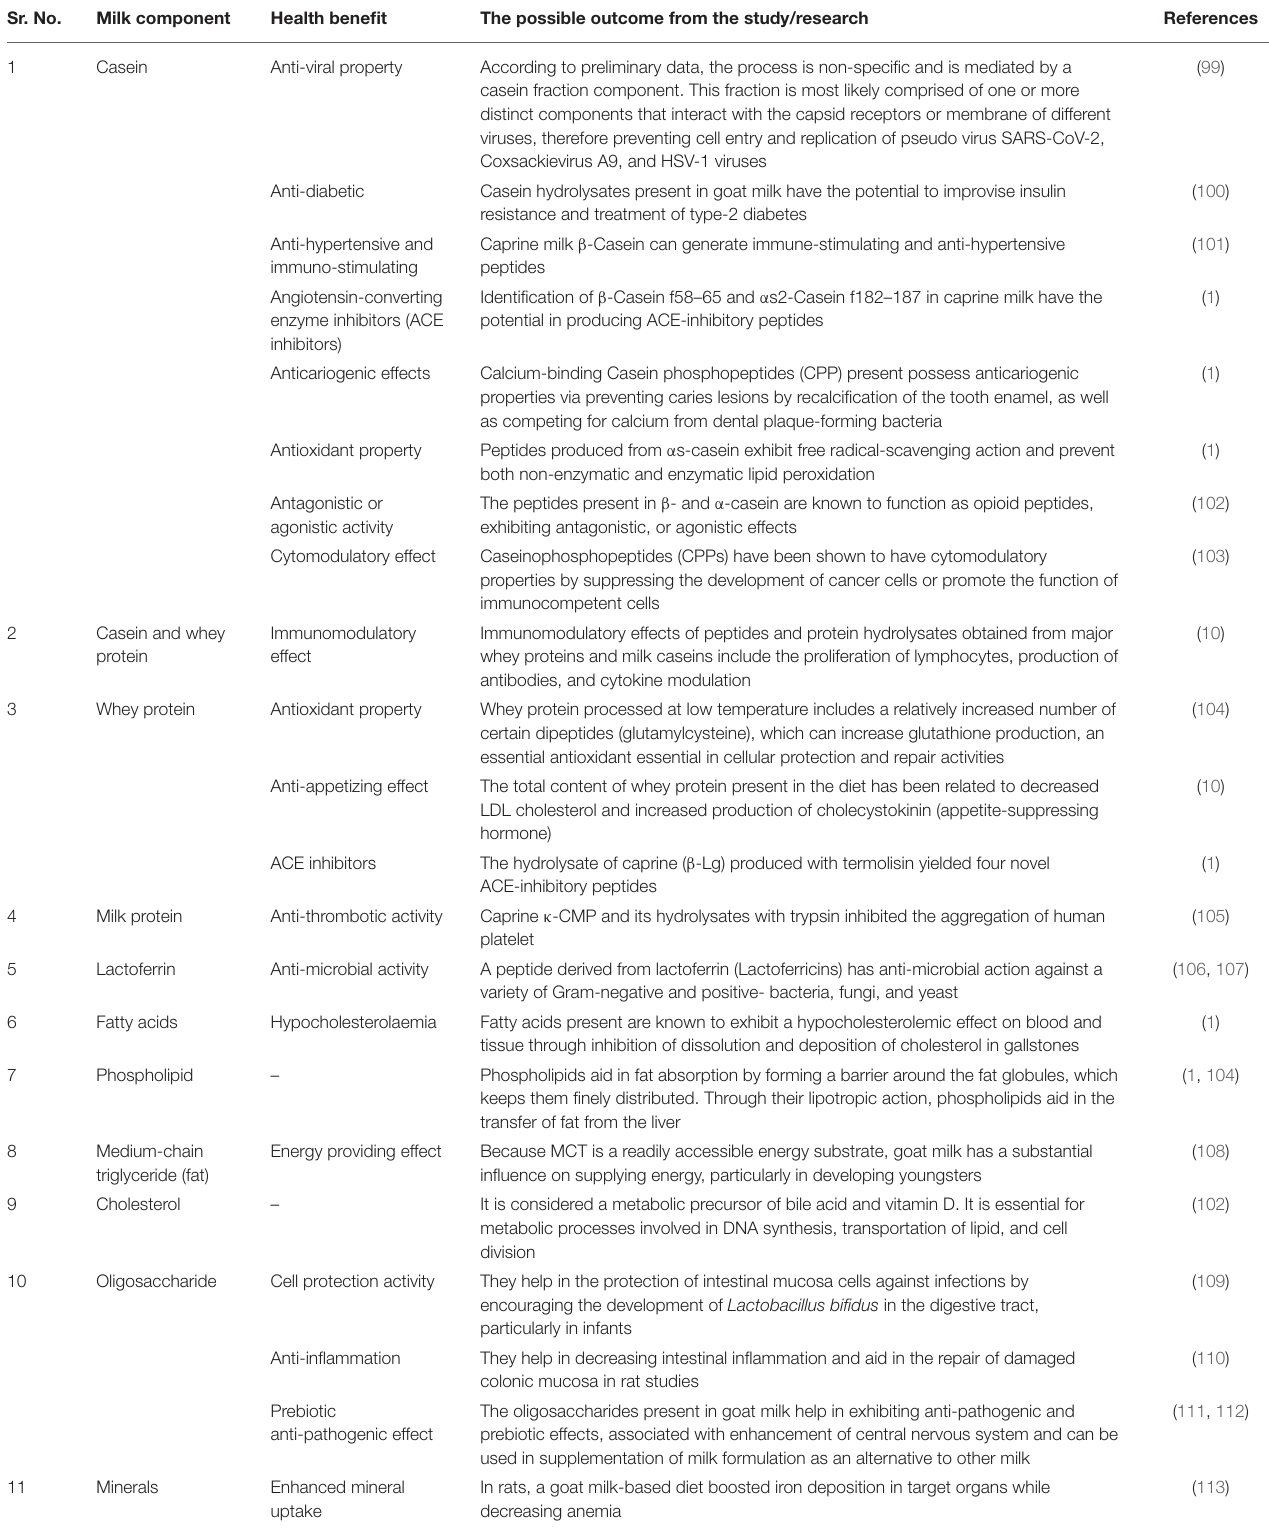
TABLE 3 | Health benefits of goat milk. Sr.